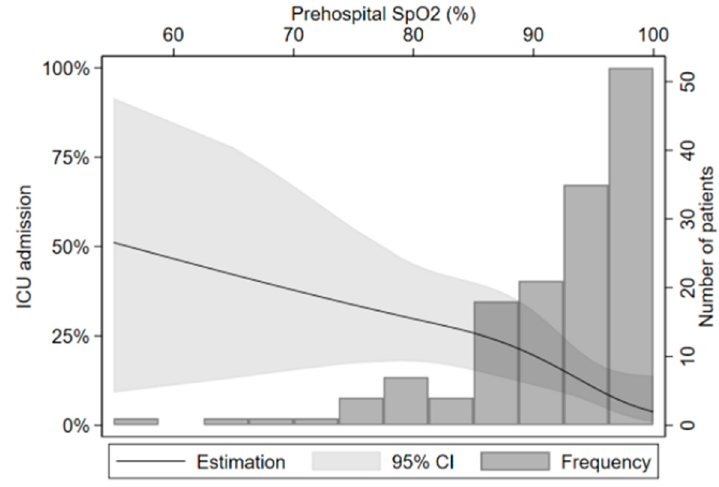
Figure 2. Association between oxygen saturation and ICU admission.